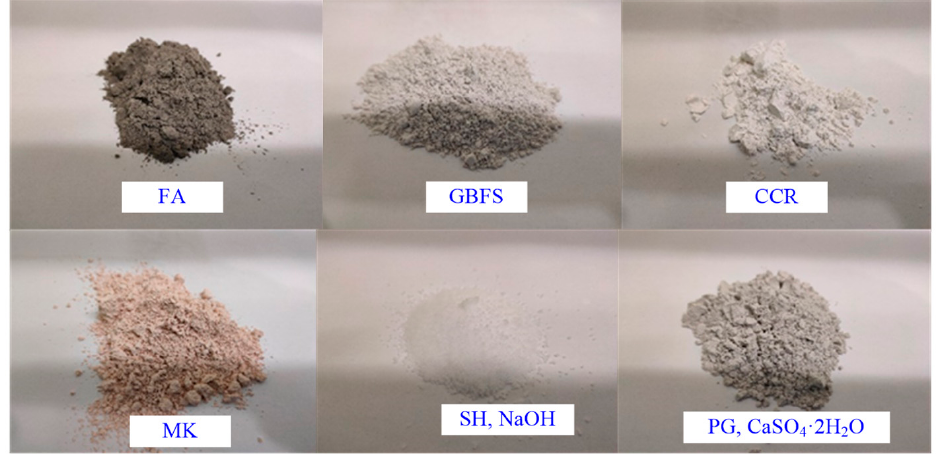
Figure 1. Raw material components of the waste-based binder. FA, fly ash; GBFS, ground blast furnace slag; CCR, calcium carbide slag; MK, metakaolin; SH, sodium hydroxide; PG, plaster gypsum.